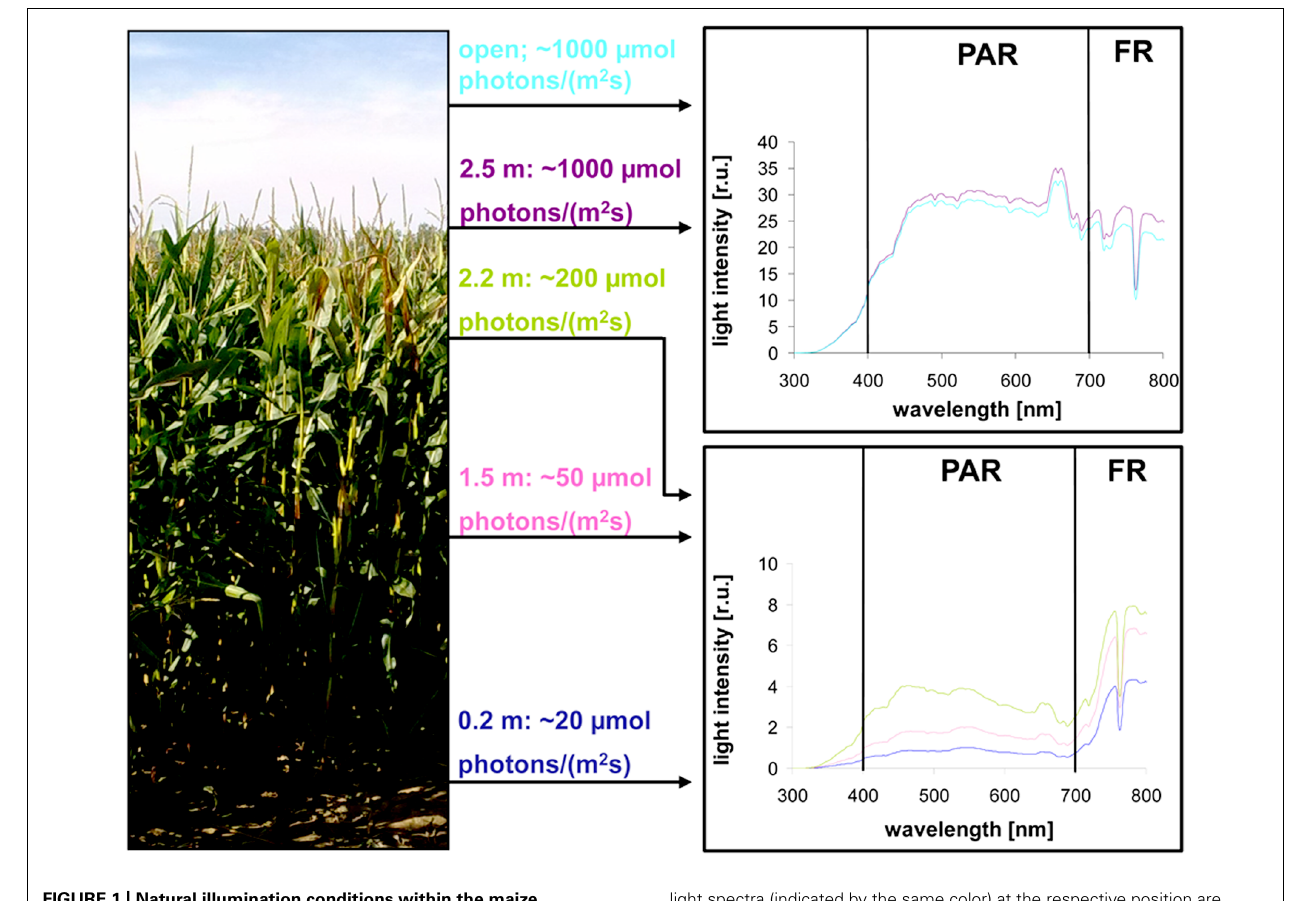
FIGURE 1 | Natural illumination conditions within the maize field used for sampling. Left picture displays the plant stand used for measurements. Light intensities determined at indicated heights within the stand are given in the middle panel. Corresponding